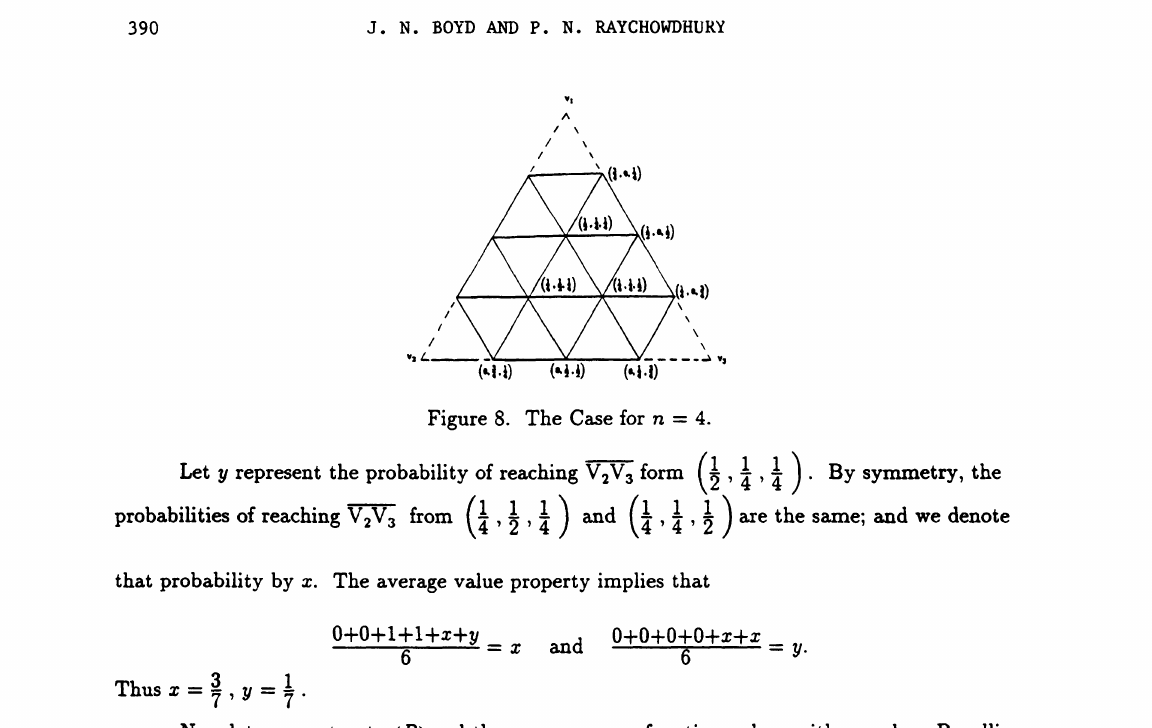
Figure 8. The Case for n